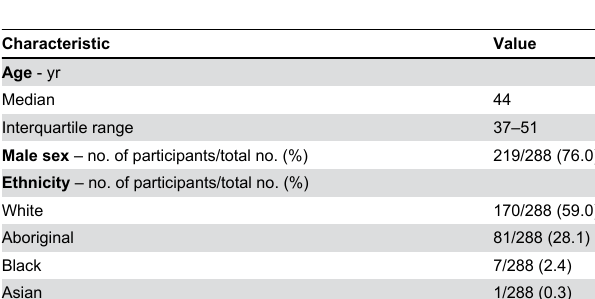
Table 1. Demographic measures and Composite Harm Score